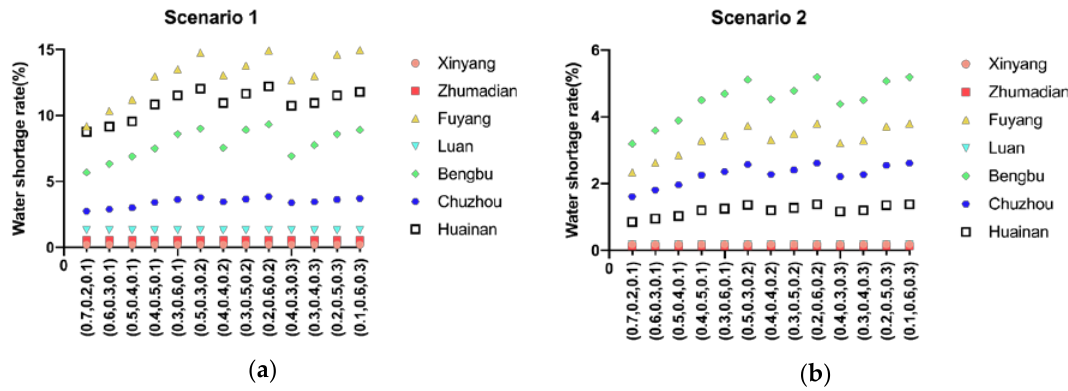
Figure 4. Water shortage rate of di ff erent subareas with di ff erent sets of objective weights (( a ) 2020, ( b ) 2050, (0.7 0.2 0.1) means ω 1 = 0.7, ω 2 = 0.2, ω 3 =